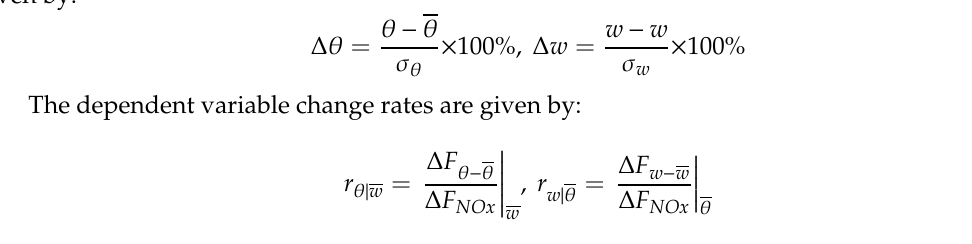
) varied with the wind direction / speed change w | θ